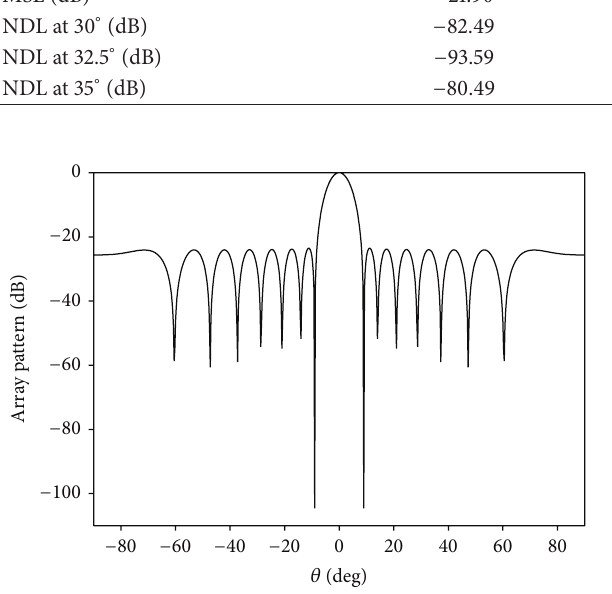
Figure 13: 28-element array pattern found by position only control with triple null at 30 ∘ , 32.5 ∘ , and 35 ∘ .